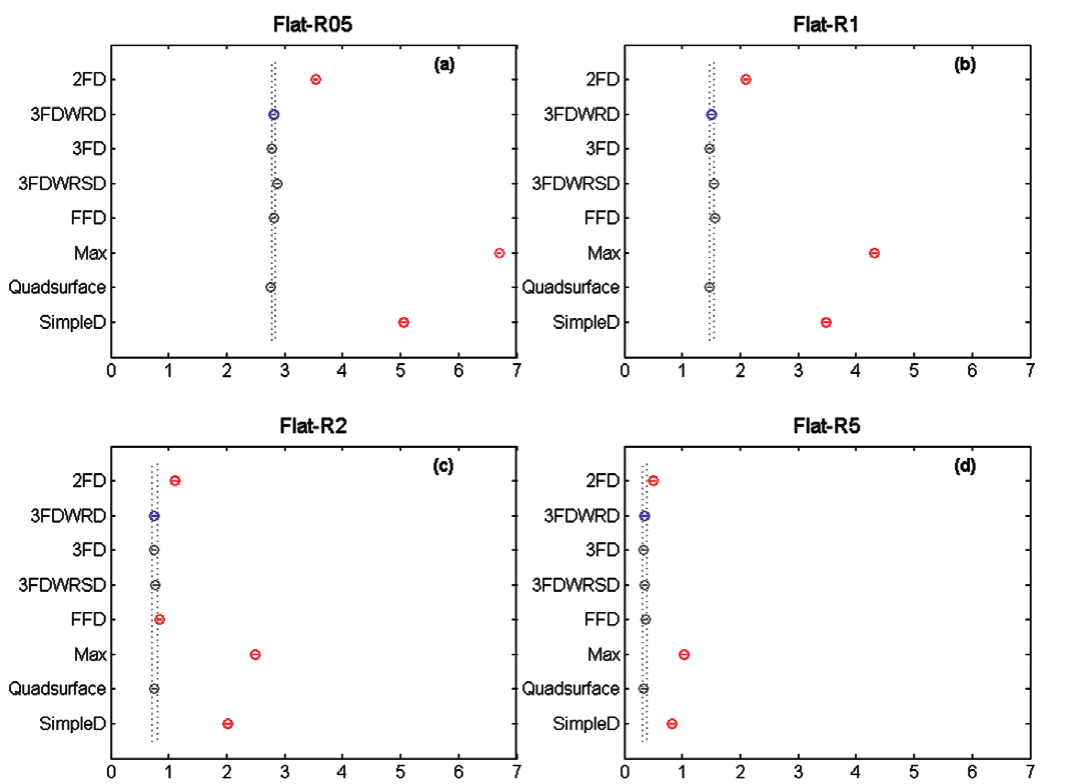
Fig. 4. Pair-wise comparisons of eight algorithms at four levels of resolution in the flat area. Flat-R05 represents 0.5 meter resolution in the flat